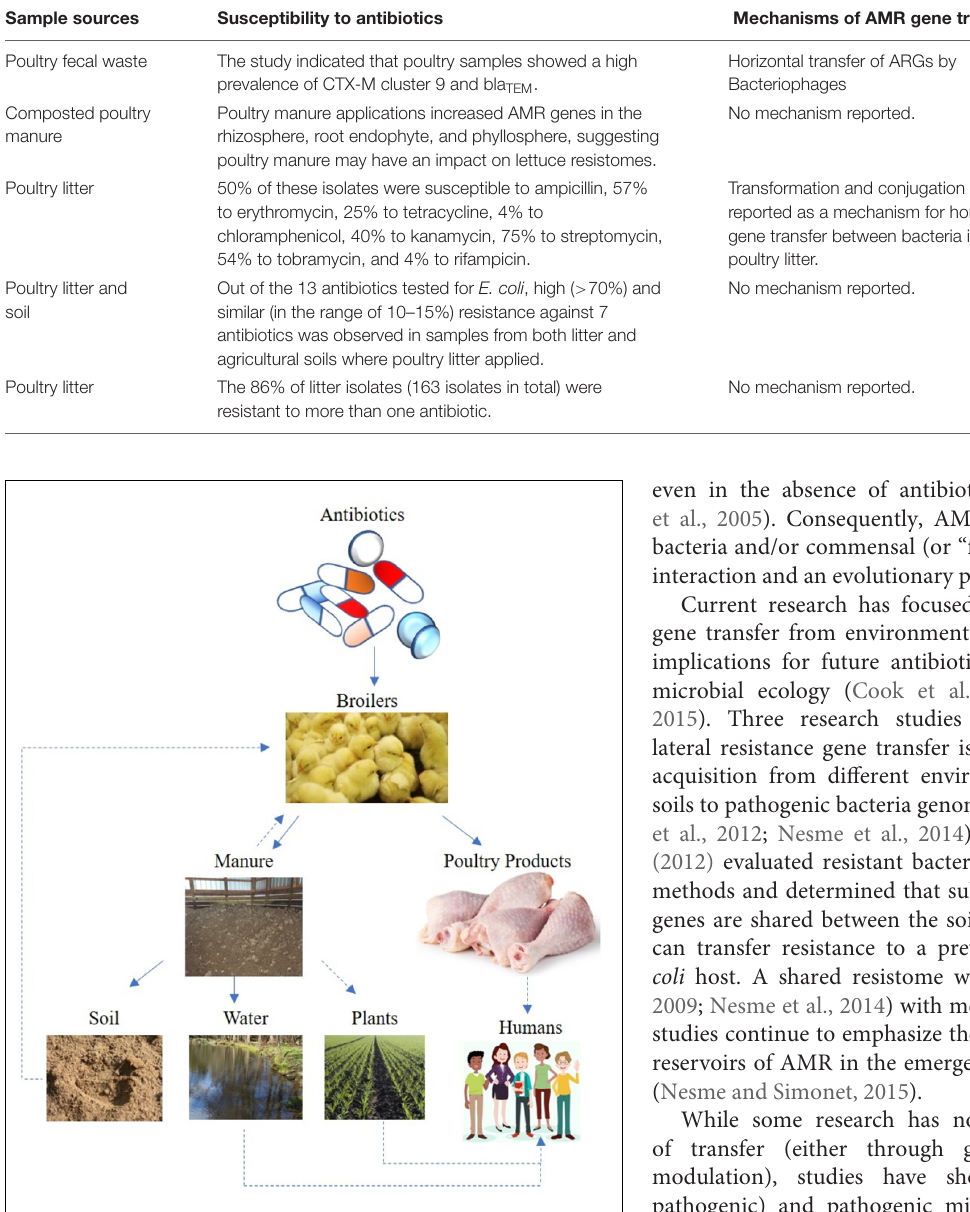
FIGURE 1 | Potential AMR transmission route from broiler chicken antibiotic induction – to flock – to either poultry litter or meat products and to the soil-water environment. Solid lines suggest direct transmission, while dotted lines indicate indirect or possible transmission